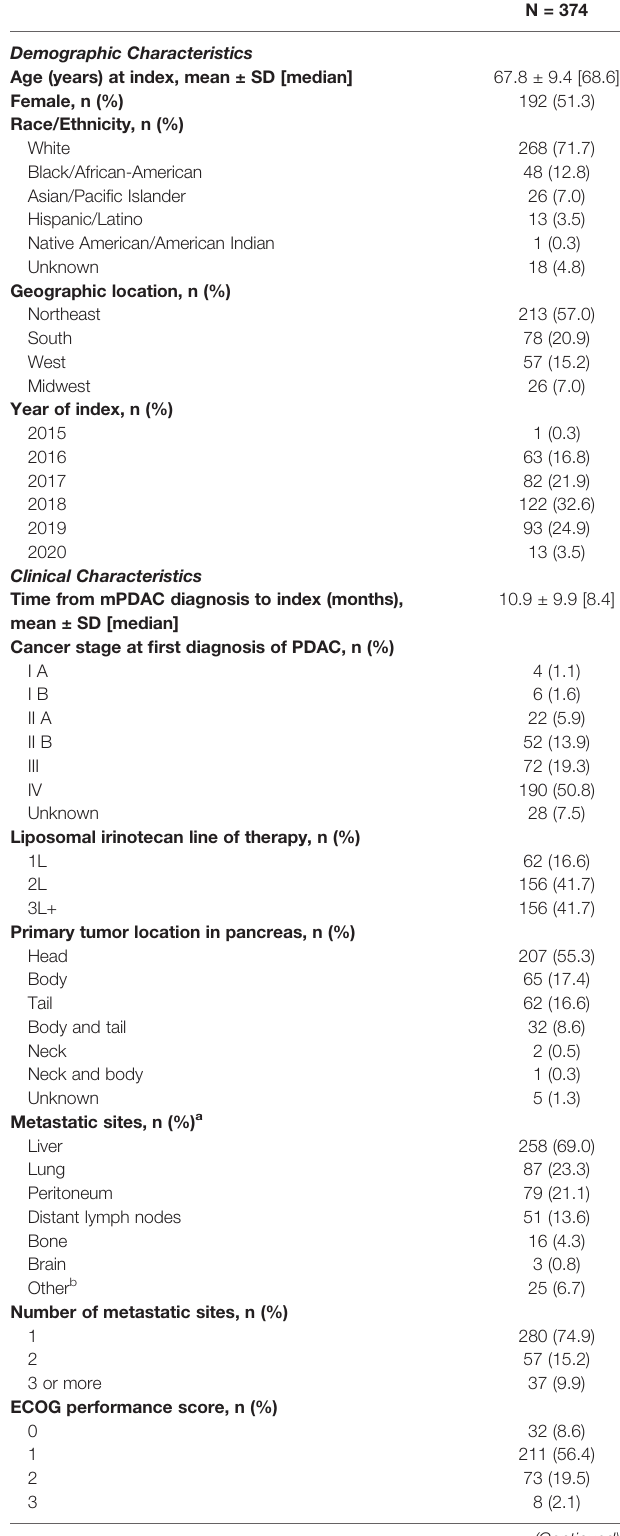
TABLE 1 | Baseline demographic and clinical